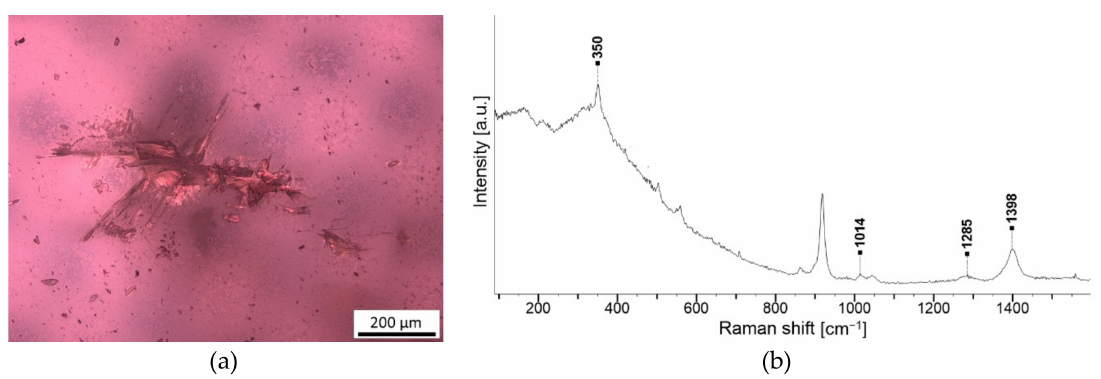
Figure 13. Inclusion in garnet G2 of fibula NA806. ( a ) Inclusion deformed by tension fissures. Reflected light, parallel polars; ( b ) Raman spectrum of inclusion with strong luminescence and Raman bands at ~1014 cm − 1 , ~1286 cm − 1 and ~1399 cm − 1 indicating presence of zircon in almandine garnet.